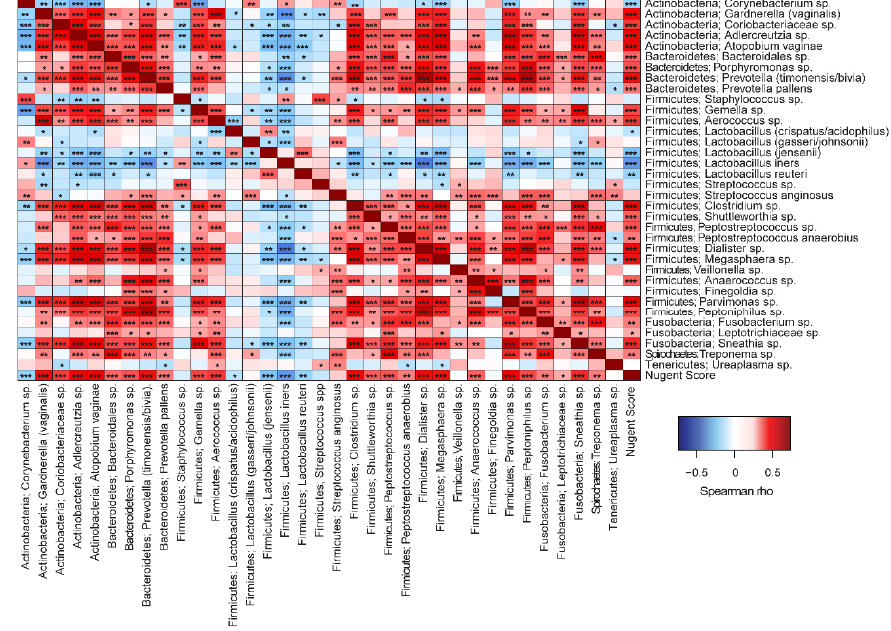
Figure 7. Spearman correlation analyses between vaginal microbiota species and to Nugent Score.